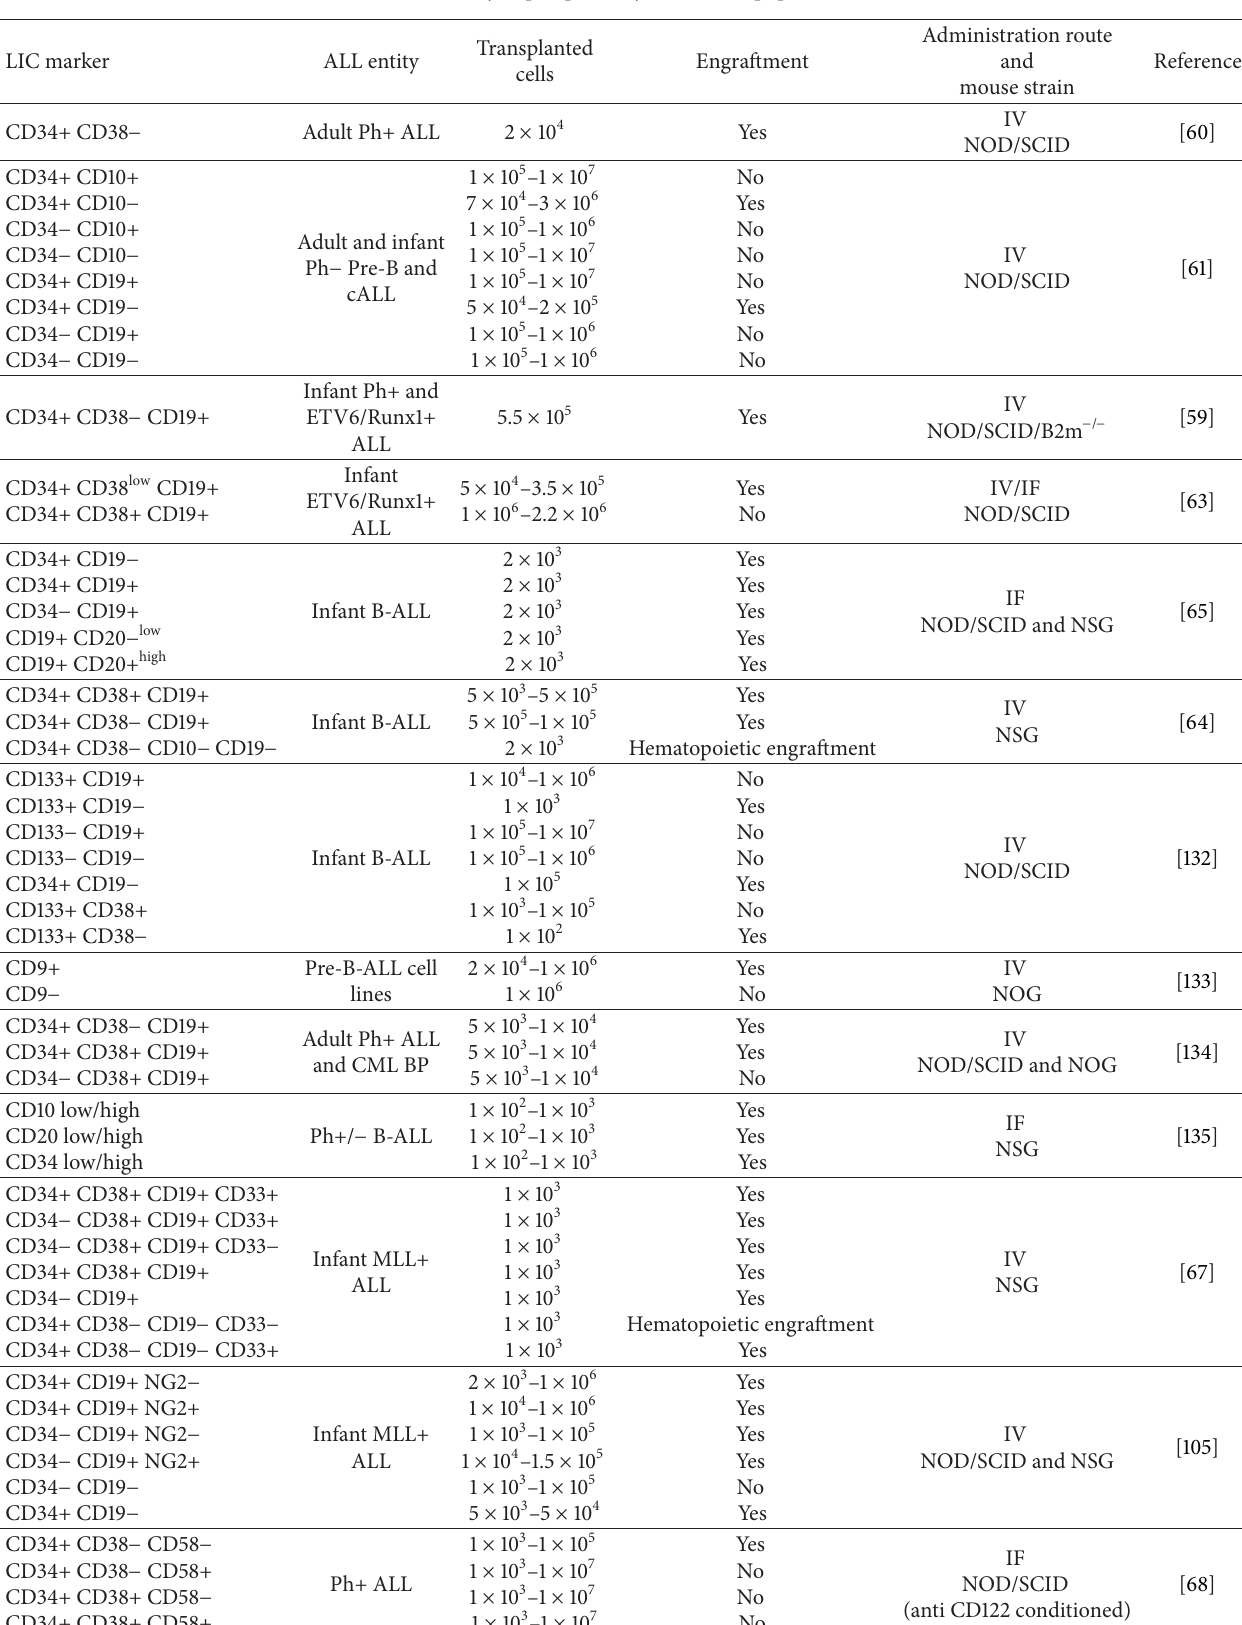
Table 1: LIC activity in prospectively isolated subpopulations in